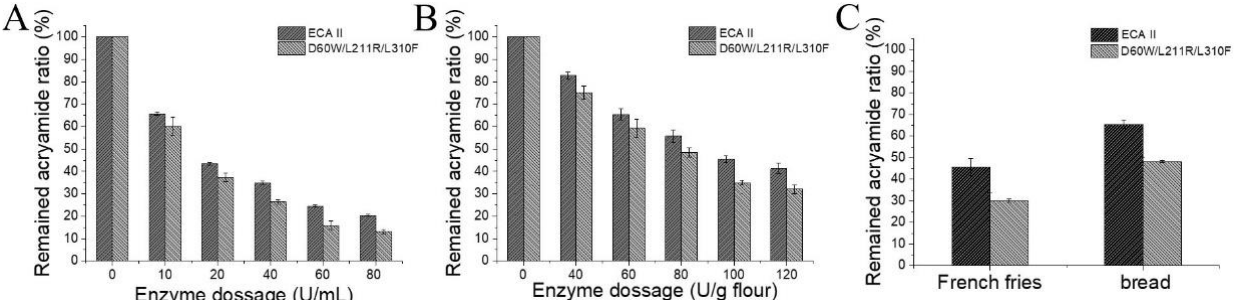
Figure 4. Effect of ECA and its mutation D60W/L211R/L310F on acrylamide formation in French fries and bread. ( A , B ) Effect of different concentrations of the enzyme on acrylamide formation in French fries ( A ) and bread ( B ) under optimum conditions. ( C ) Effect of the enzyme on acrylamide formation in French fries and bread under uncontrolled conditions.